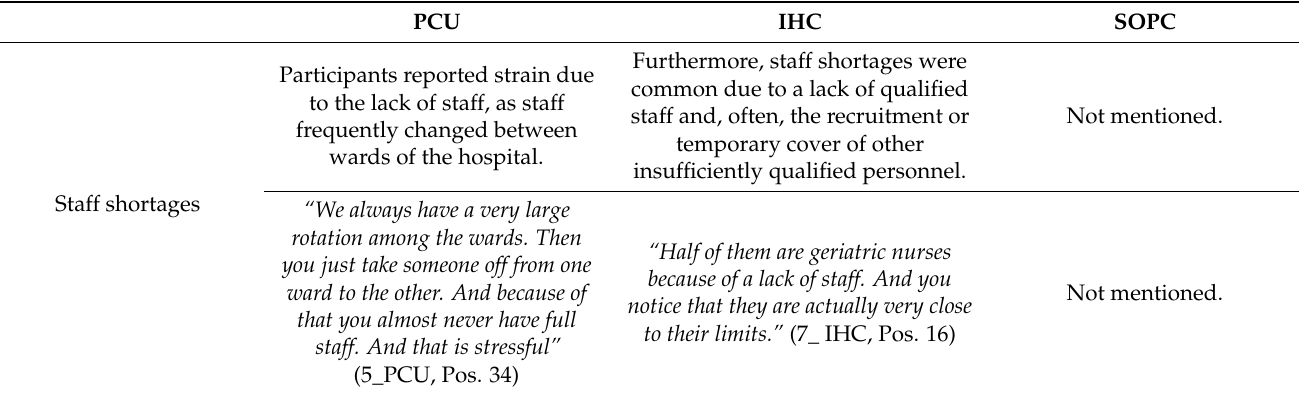
Table 2. Sub-categories of burden due to working conditions. PCU